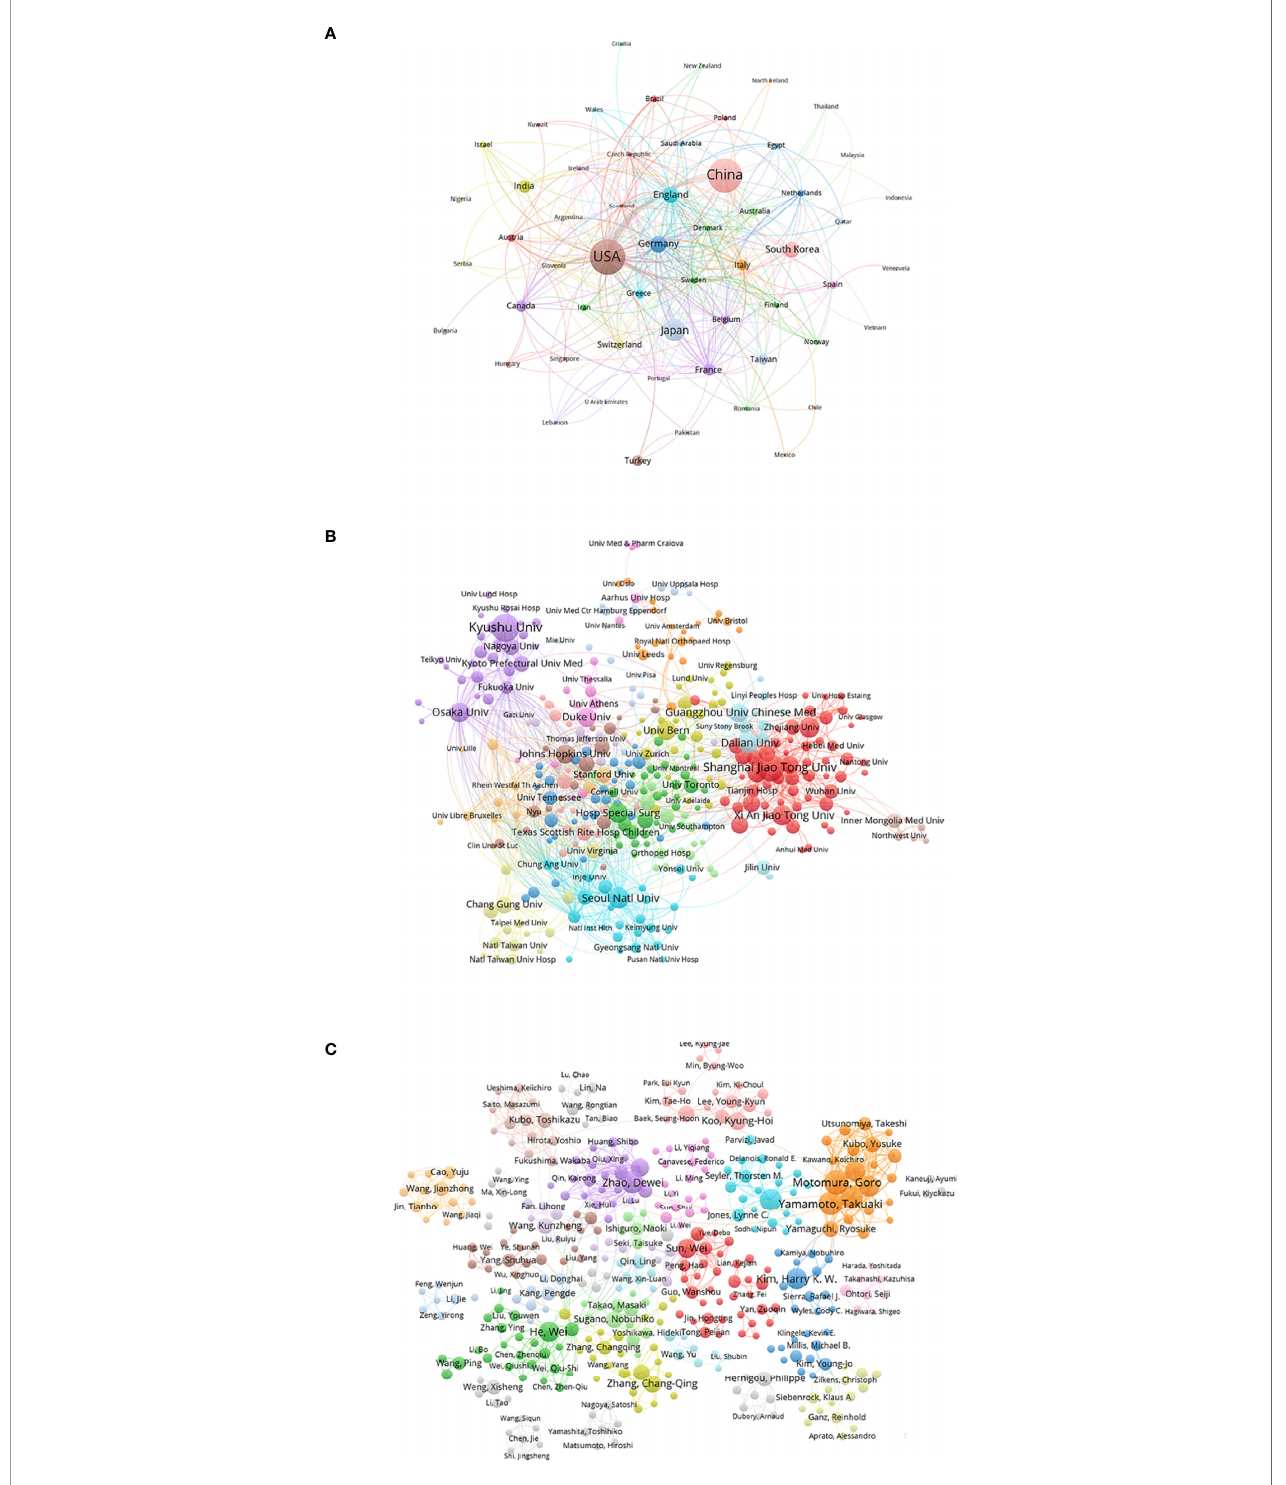
FIGURE 6 | Co-authorship analysis of global publications in ONFH in the last 30 years. (A) Network visualization of the 59 identi fi ed countries in ONFH. (B) Network visualization of the 405 identi fi ed institutions in ONFH. (C) Network visualization of the 629 identi fi ed authors in ONFH. In the visualized network, each item is represented by a circle. The size of the circle is determined by the number of publications of the item. The distance between two circles approximately indicates the relatedness of the items. Item color is determined by the cluster to which the item